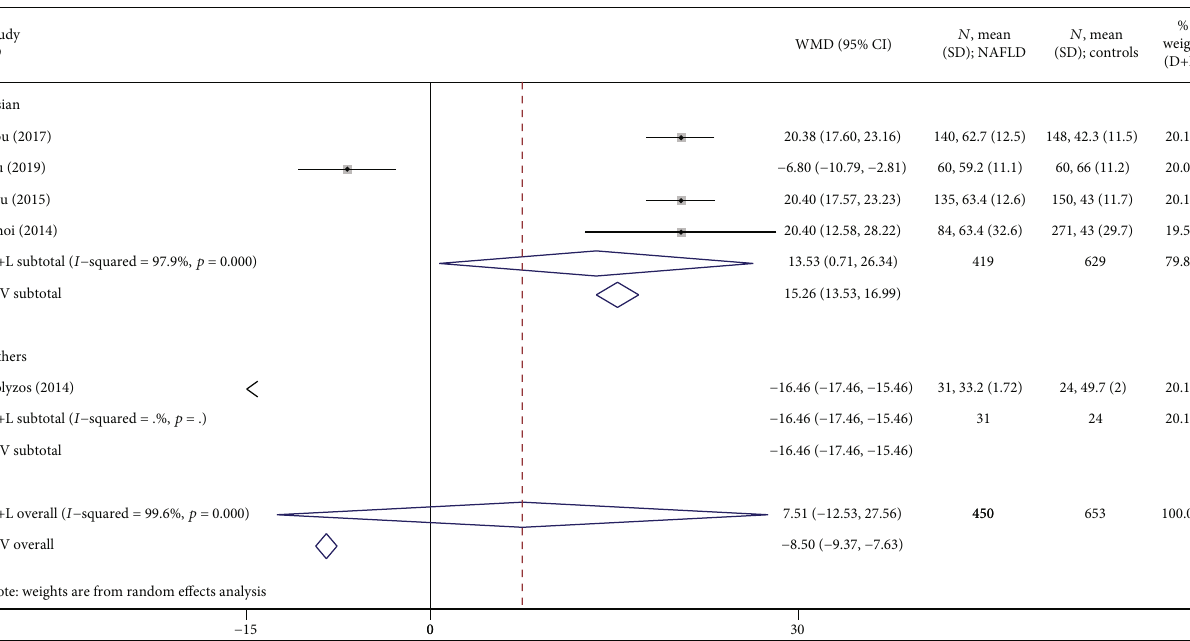
Figure 3: Forest plot analyzing the circulating irisin levels between the NAFLD group and healthy group by races.